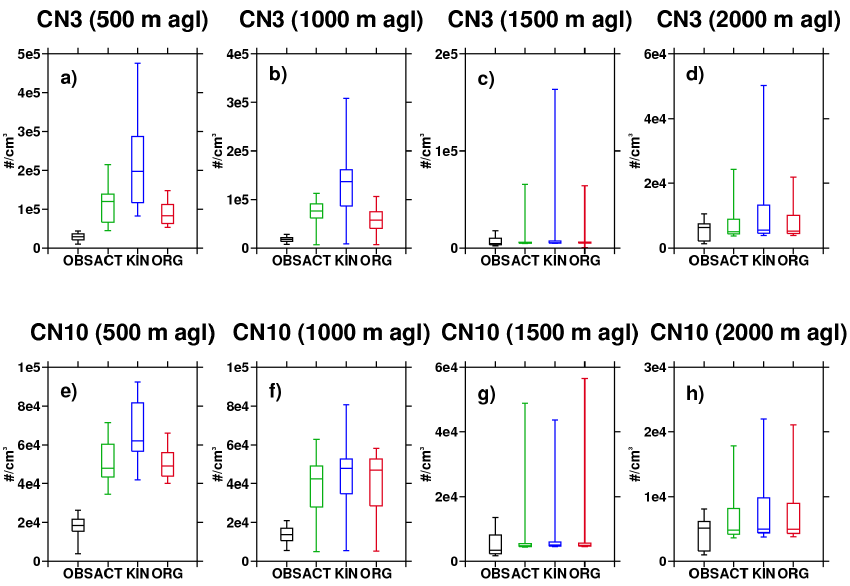
Figure 18. Boxplot for observed and simulated CN 3 and CN 10 at the surface to 500m altitude ( a and e ); 500–1000m altitude ( b and f ); 1000–1500m altitude ( c and g ); and 1500–2000m altitude ( d and h ) for the 8 June 2010 afternoon G-1 flight. Observations are in black, ACT simulation values are in green, KIN in blue, and ORG in red. The line in the middle of each box is the median, while the boxes represent the 25th and 75th percentiles, and “whiskers” the 5th and 95th percentiles.